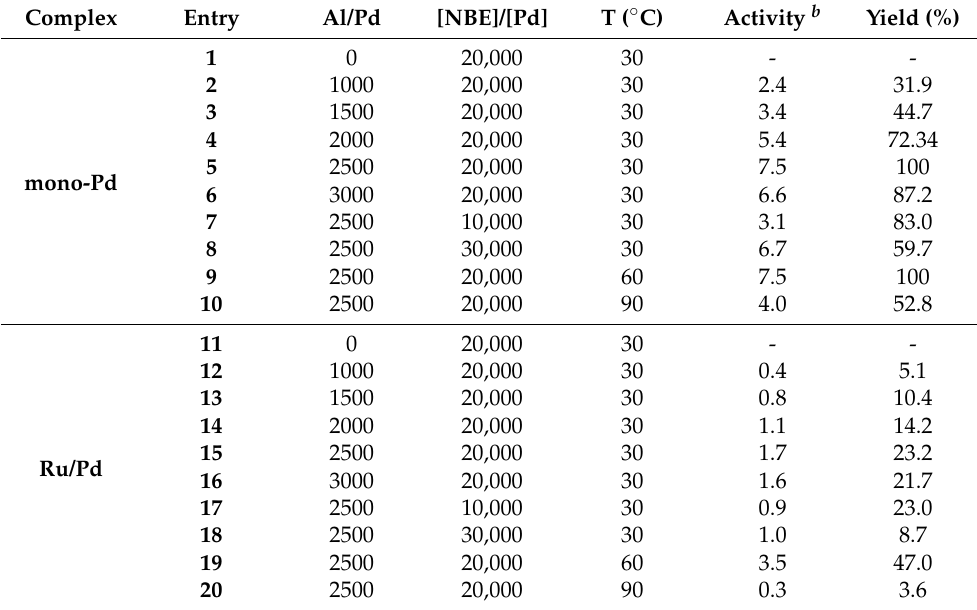
Figure 4. Catalytic activity as function of Al/Pd molar ratio. V total = 10 mL, [NBE]/[Pd] = 20,000, mono-Pd and Ru/Pd = 2.5 µ mol, and polymerization reaction at 30 ◦ C for 15 min. Table 2. Polymerization of NBE with mono-Pd and Ru/Pd activated by MAO a